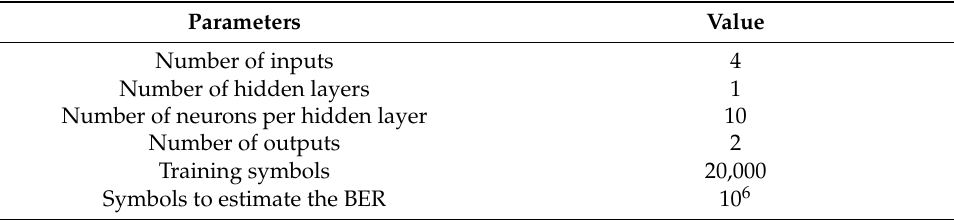
Table 3. FNN parameters. Table 2. MCF parameters.